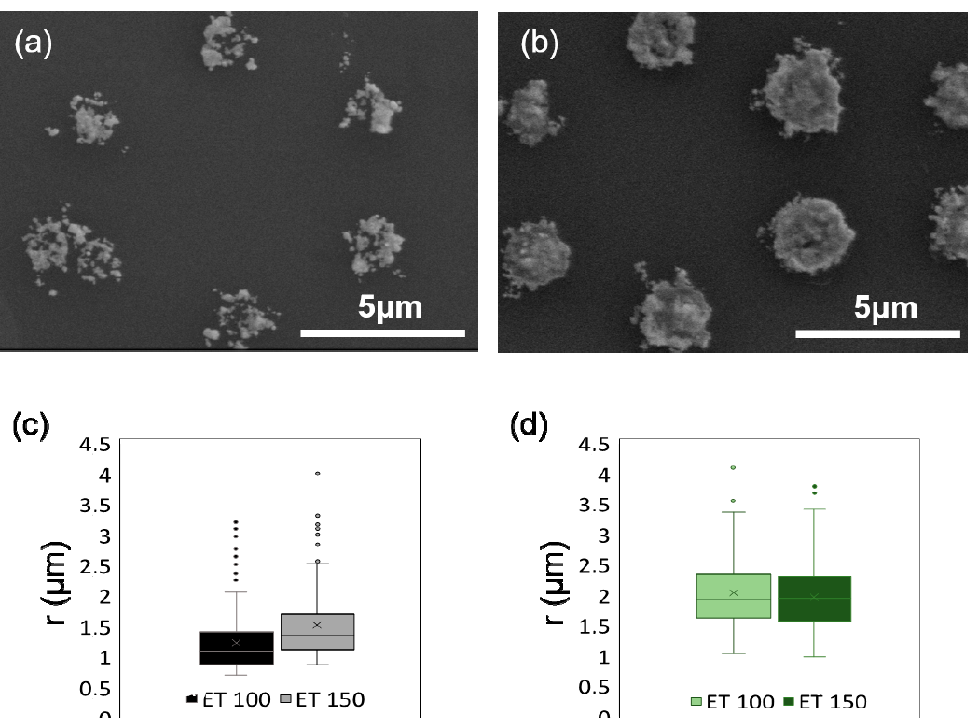
Figure 3. SEM micrographs showing AuNSs fabricated via TPA–DLW using an ET = 150 ms and ( a ) LP = 40 mW; ( b ) LP = 100 mW. Box plots comparing the radius of the different AuNSs printed with different ET at ( c ) LP = 40 mW and ( d ) LP = 100 mW. Box plots were made in all cases from at least 180 independent measurements ( N > 180).